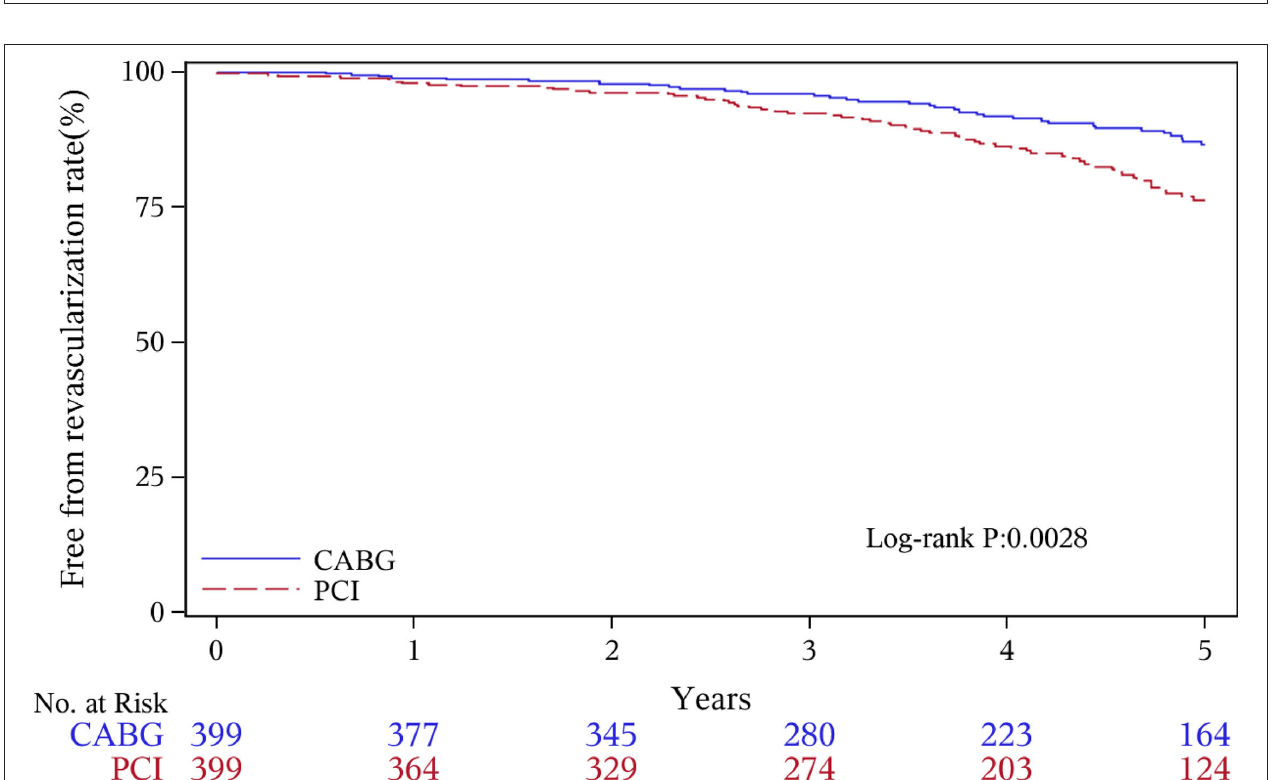
FIGURE 4 | Revascularization Kaplan–Meier (1–5 years).